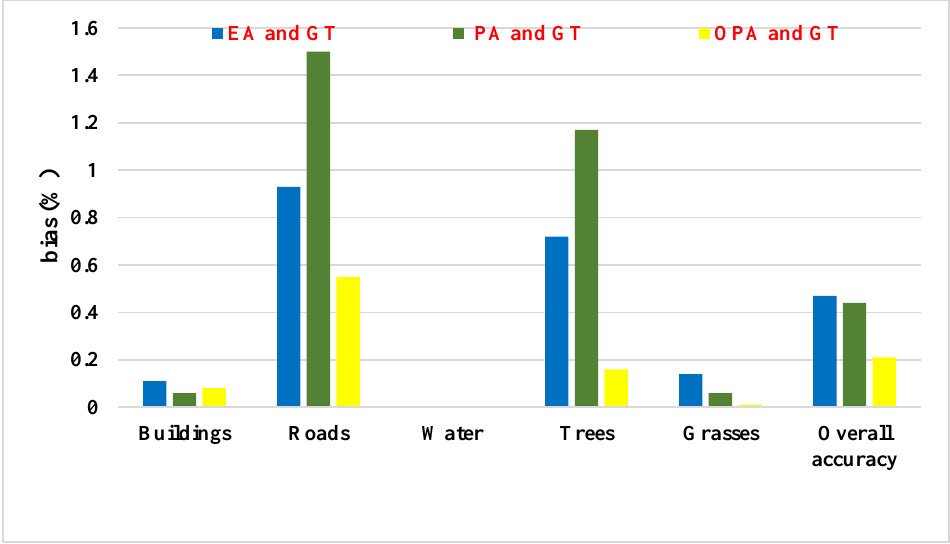
Figure 5. Sample allocation based on the three different methods.